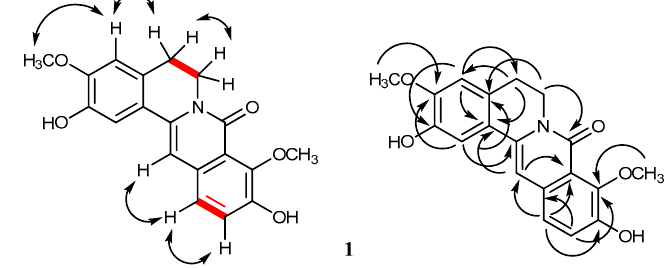
Figure 2. COSY (bold line), NOESY (double arrow line), and HMBC (arrow line) correlations observed for 1 .